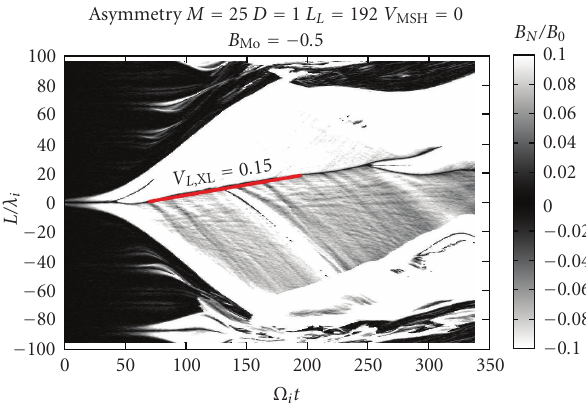
Figure 13: The same as Figure 9(b) but for the smaller mass ratio/larger simulation box case of ( V MSH , B Mo ) = (0, − 0 . 5). It shows that V L ,XL is constant for an extended time interval.